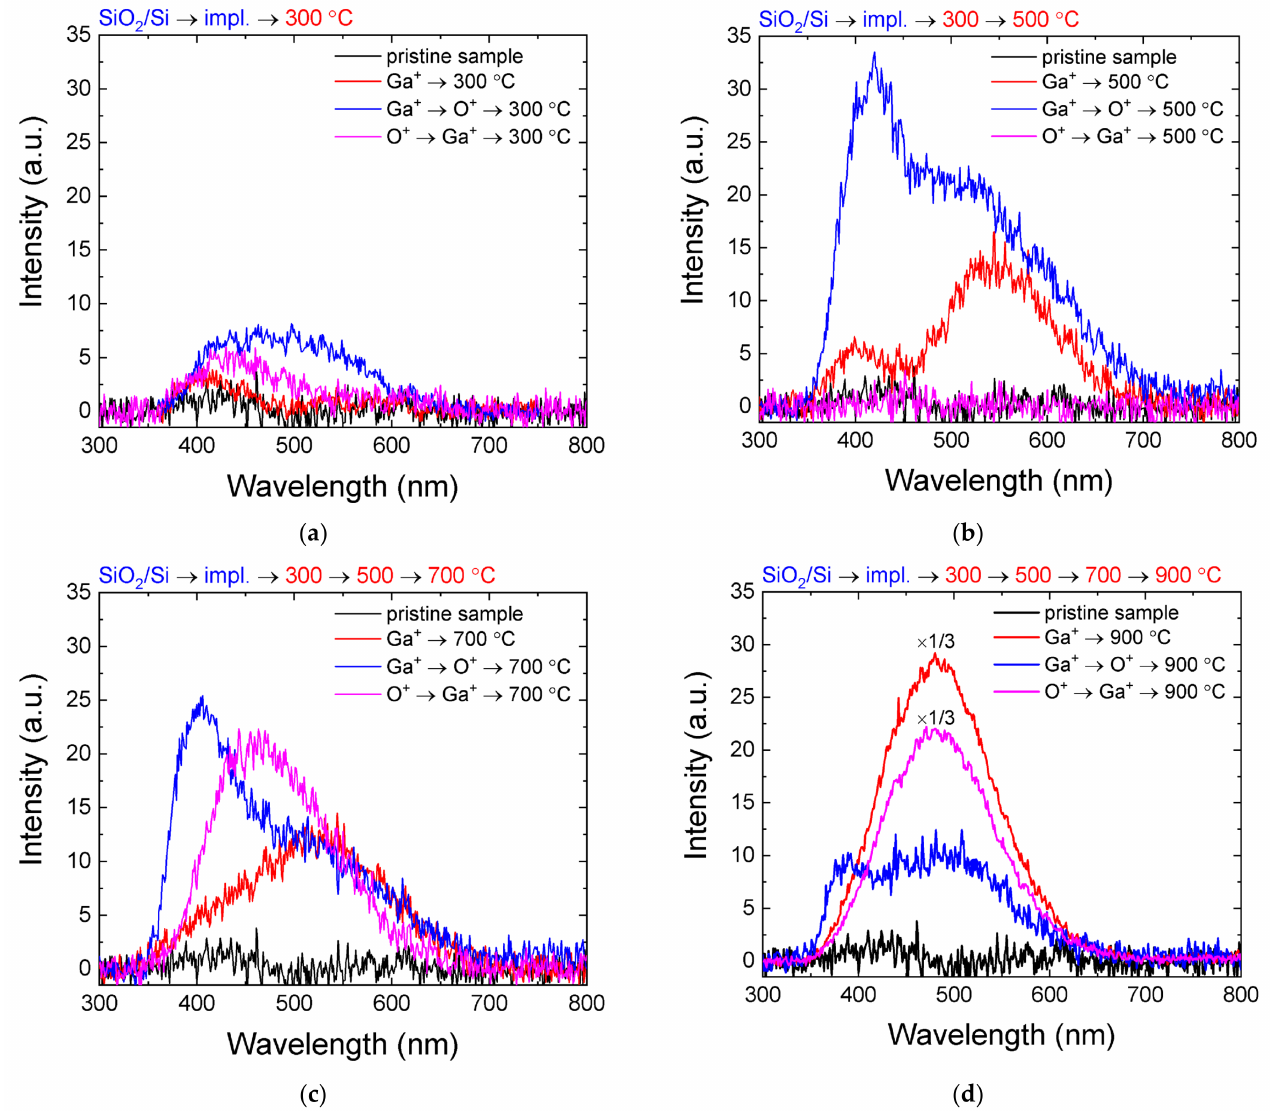
Figure 3. PL spectra of SiO 2 /Si samples irradiated with gallium and oxygen ions in different regimes after sequential annealing: ( a ) at 300 ◦ C; ( b ) at 500 ◦ C; ( c ) at 700 ◦ C; ( d ) after final annealing at 900 ◦